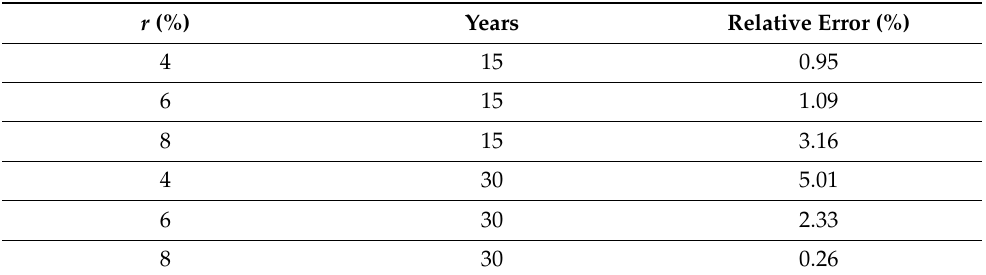
Figure 18. Deviation of the model LCOE with respect to the calculated LCOE. These differences have been calculated for the base case of area 1 and are equivalent to those obtained for other facilities, since the precision of the approximation used causes the error. Table 11 shows the relative error of the LCOE calculation. Table 11. Relative error of the LCOE calculation approximation as a function of the parameters